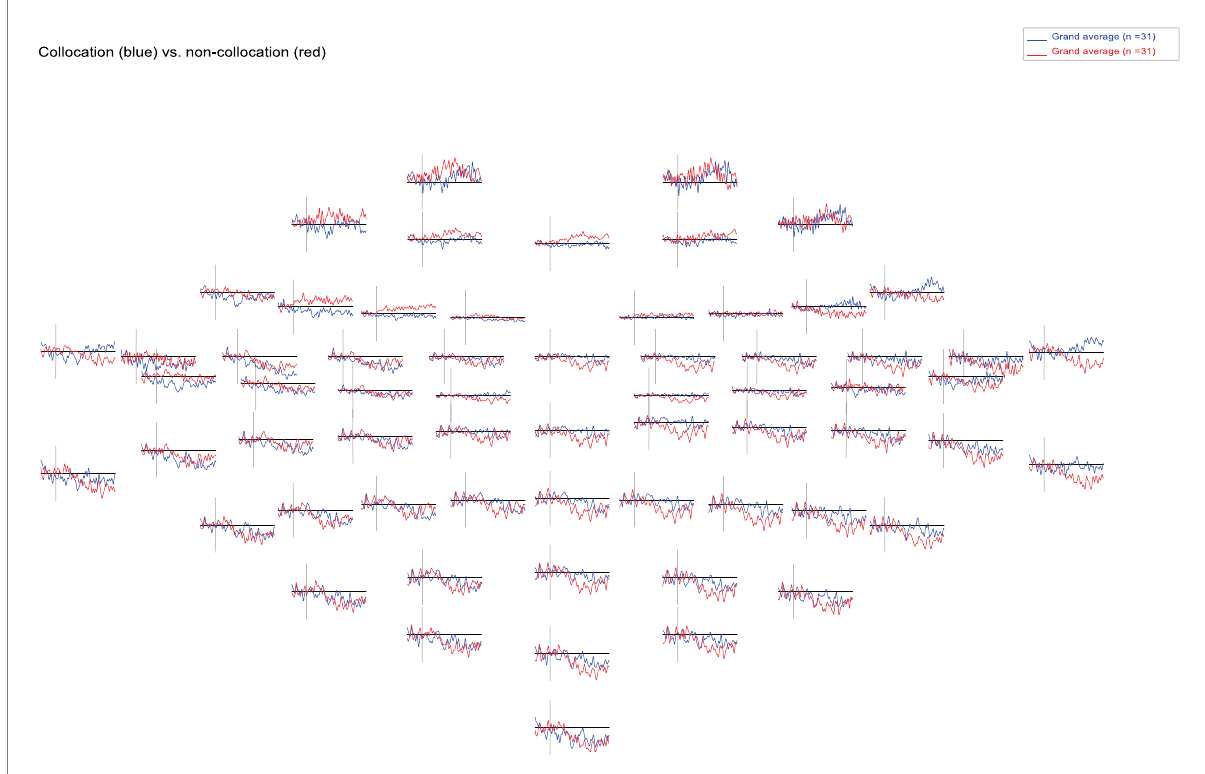
FIGURE 2 Topomap of grand averages of ERPs for collocations and non-collocations. Collocations (blue) cause larger N400 amplitudes in anterior brain regions symmetrically in both hemispheres compared to non-collocations (red). Additionally, collocations induce a clear negativity in the lateral posterior regions of the left hemisphere. In contrast, non-collocations cause an increased N400 amplitude in the right